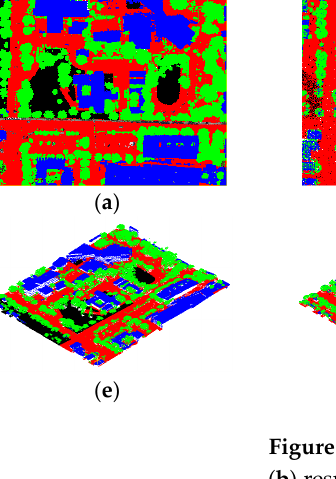
Table 2. Classification results of each type of objects with different feature subsets from different data sources.